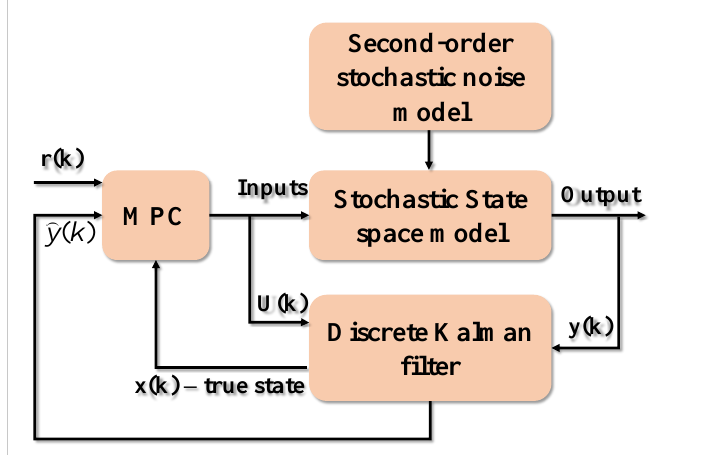
Figure 11. Stochastic MPC with Kalman